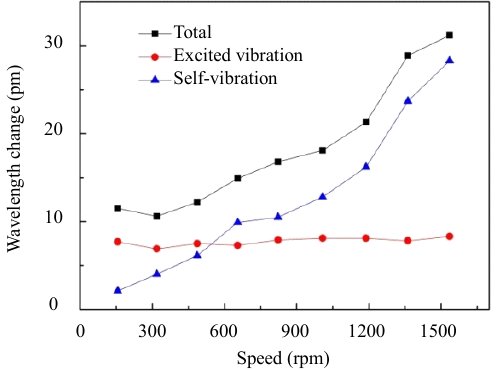
Fig. 6 Relationship between the rotational speed and wavelength of the fiber grating ( h = 0.5 mm).